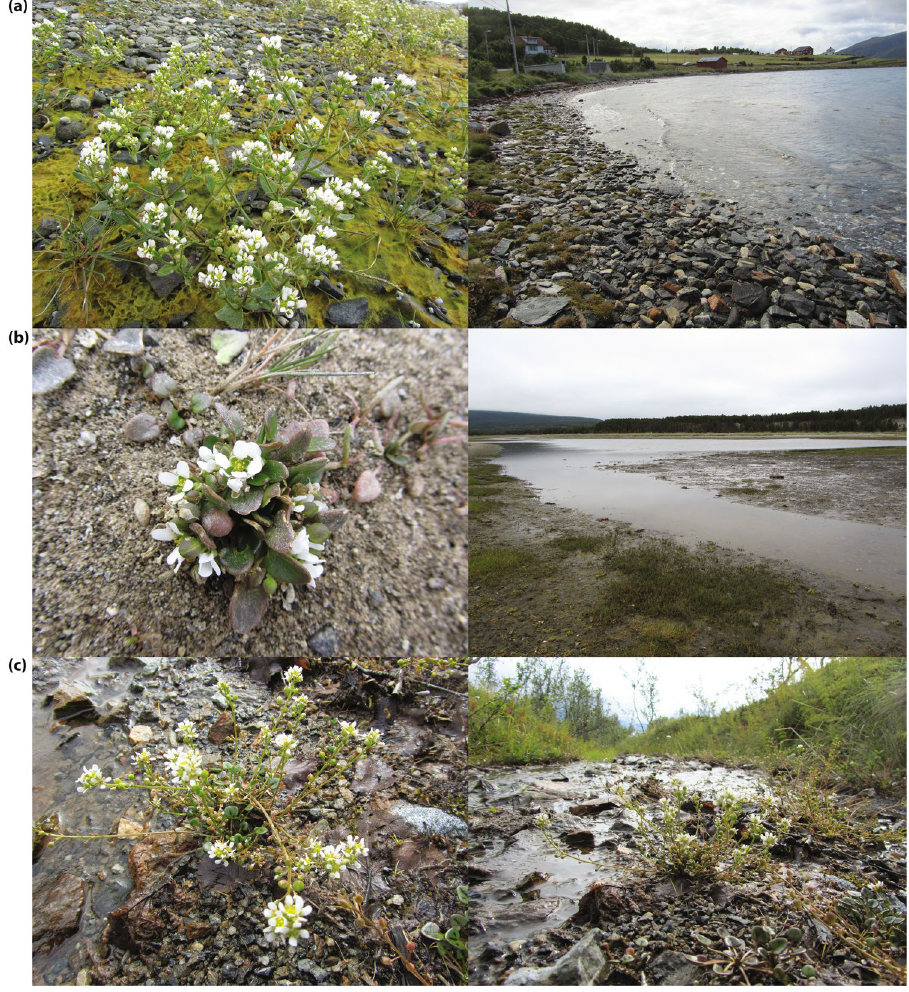
Figure 1. Habit and habitat of the three ecotypes of Cochlearia officinalis (2 n = 24) in Troms, Norway. ( a ) The beach ecotype (ssp. officinalis ) at localities Sjøvassbotn (left) and Skittenelv (right), ( b ) the estuary ecotype (ssp. norvegica ) at locality Skibotn, and ( c ) the spring ecotype (ssp. integrifolia ) at locality Kvaløysletta. (Photo: M.K.